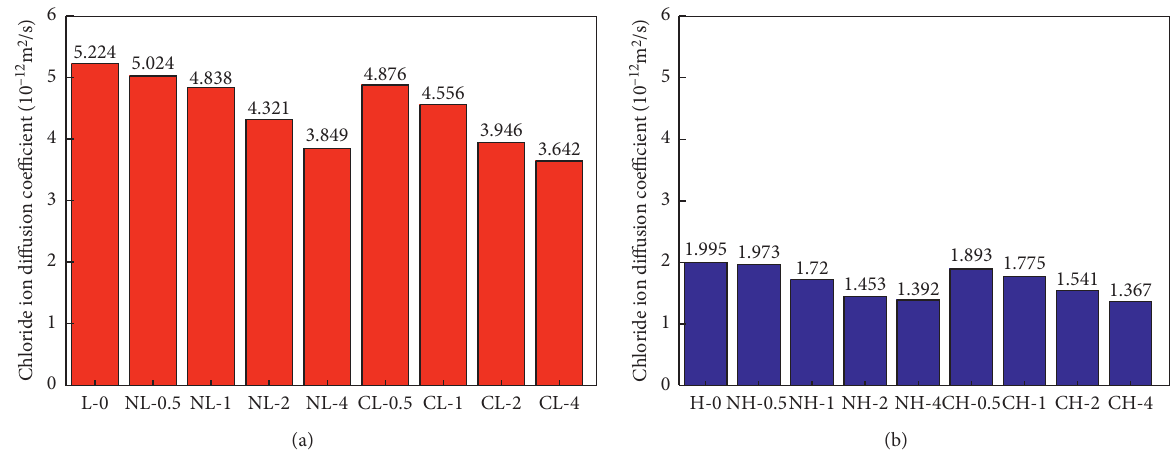
Figure 1: Chloride ion diffusion coefficient of concrete. (a) C30. (b)